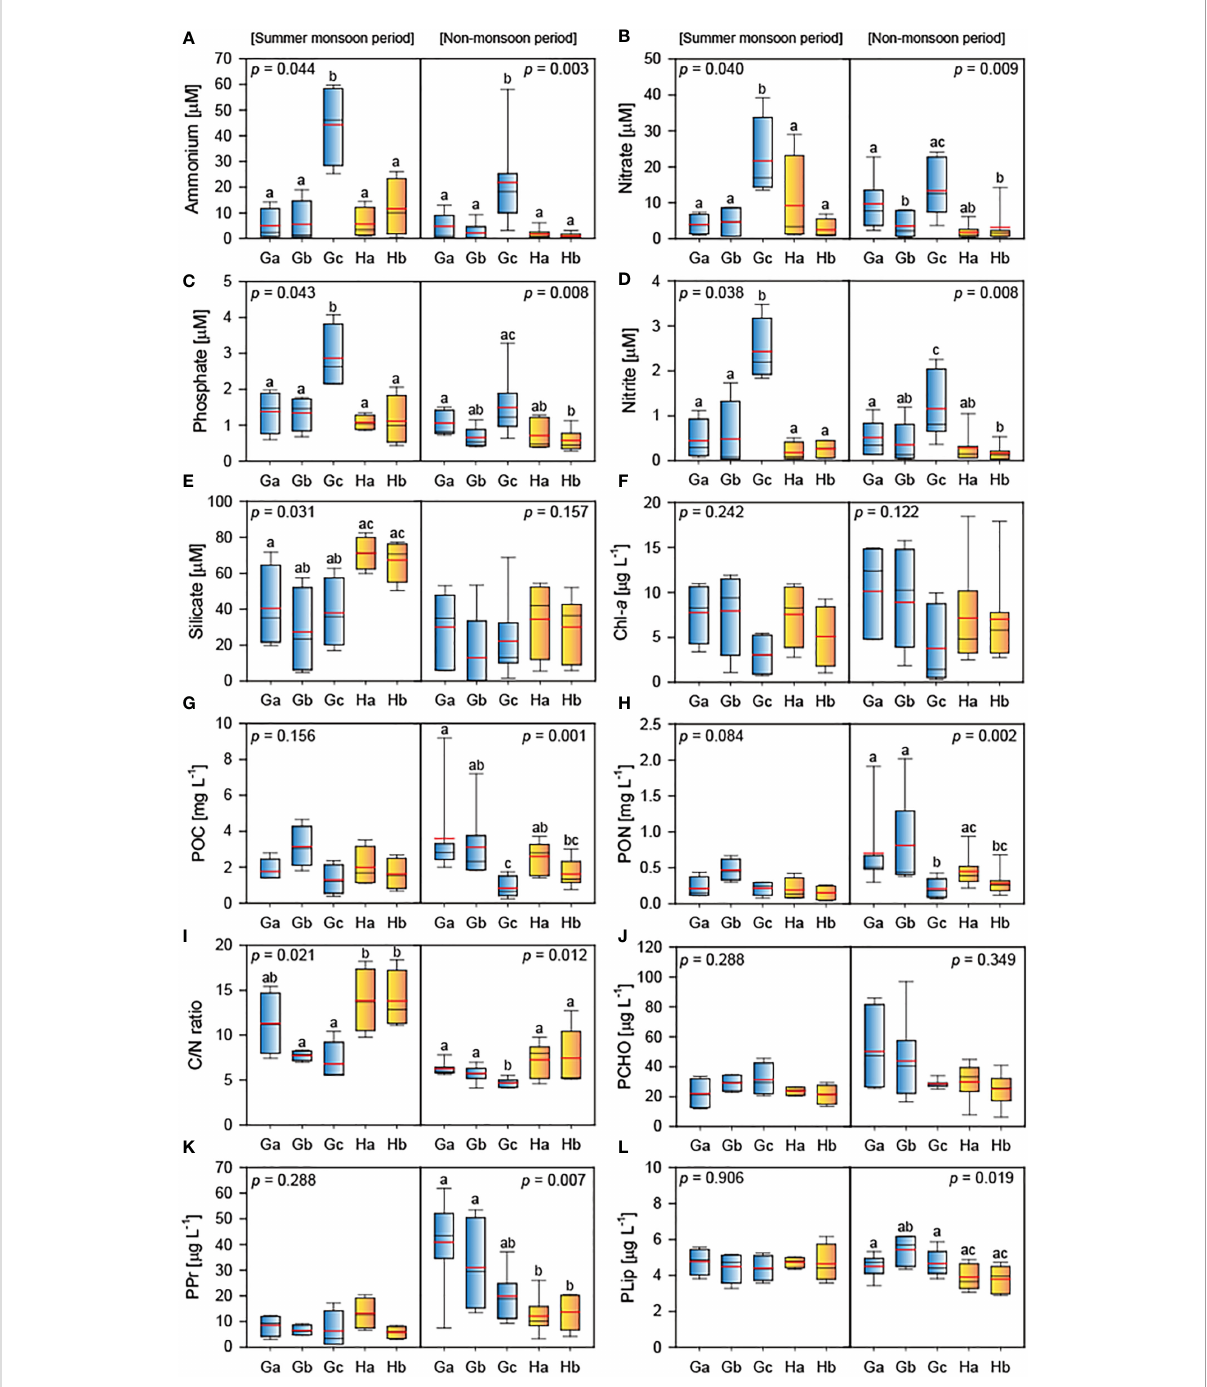
FIGURE 4 Box plots of data for summer monsoon and non-monsoon periods showing (A) ammonium, (B) nitrate, (C) phosphate, (D) nitrite, (E) silicate, (F) Chl- a , (G) POC, (H) PON, (I) C/N ratio, (J) PCHO, (K) PPr, and (L) PLip. The blue and yellow boxes represent the sites of Gyeongpoho, and Hyanho, respectively. The median and average values are displayed with the black and red horizontal bar inside the